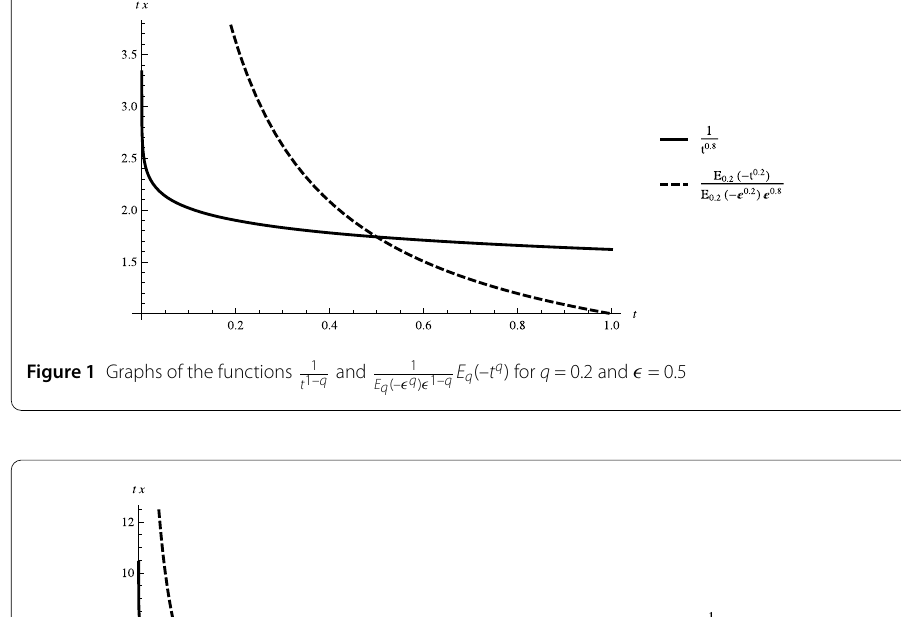
Figure 2 Graphs of the functions 1